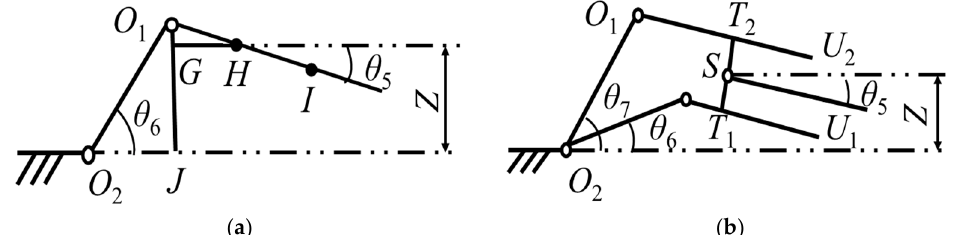
Figure 20. The schematic diagram of connecting the universal wrench with the bolt. ( a ) No eccentricity. ( b ) Eccentricity.